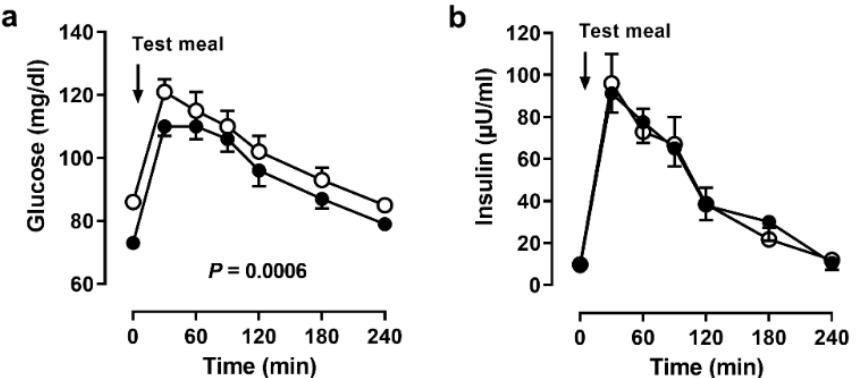
Figure 2. Systemic responses to the meal. Serum ( a ) glucose and ( b ) insulin concentrations before and after a meal in 11 men before (open circles) and during (closed circles) Bahá’í fasting. Data are presented as means (SEM), p values by ANOVA.